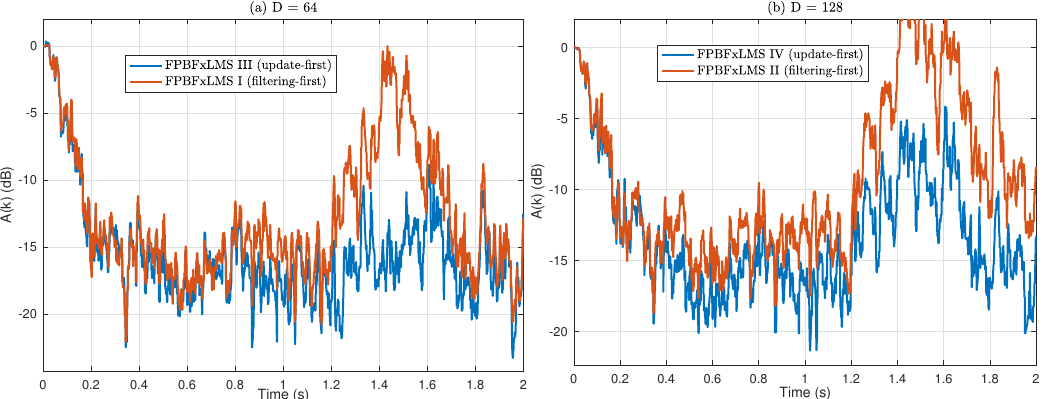
Figure 8. Convergence comparison between the update-first and filtering-first approaches. ( a ) FPBFxLMS I and FPBFxLMS III. ( b ) FPBFxLMS II and FPBFxLMS